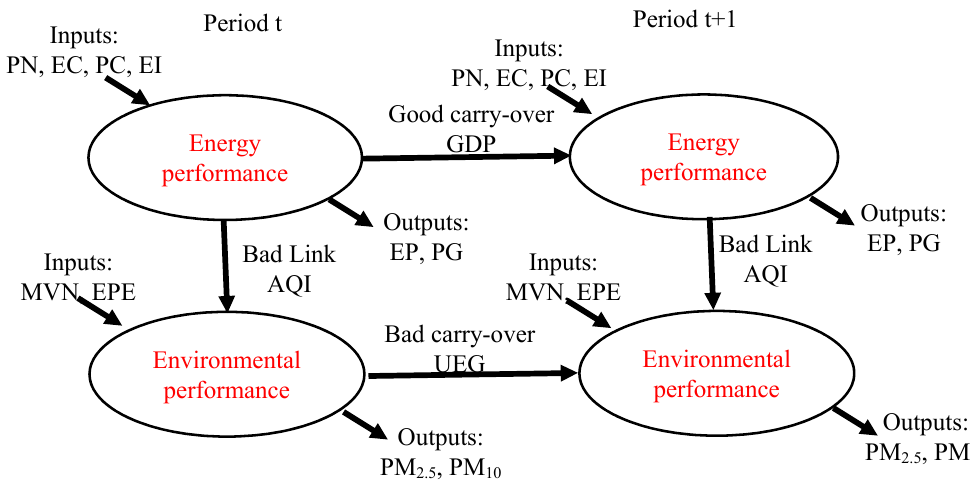
Figure 1. The structure of DN-DEA in this study.